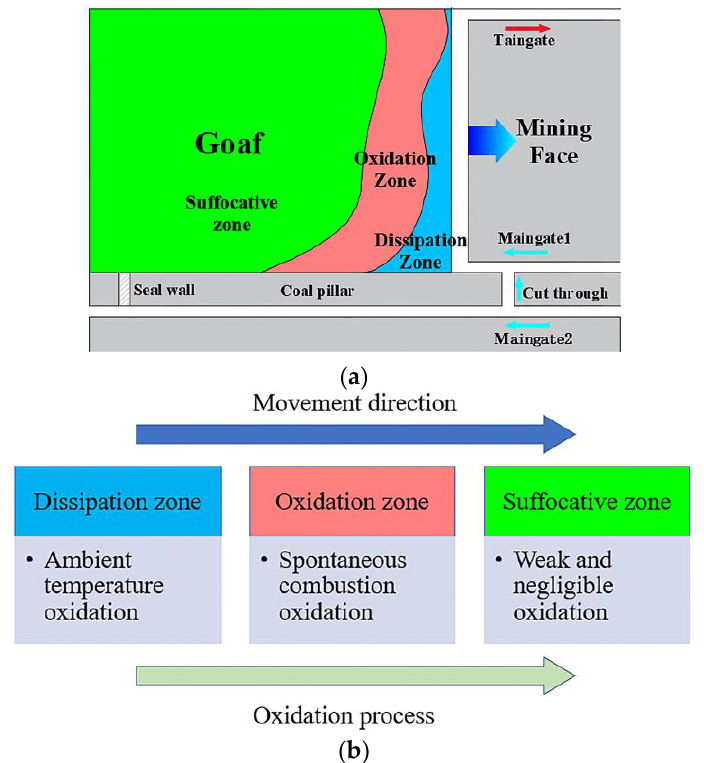
Figure 1. ( a ) “Three zones” in goaf. ( b ) Oxidation process of residual coal. Oxidation scenario of residual coal in goaf.